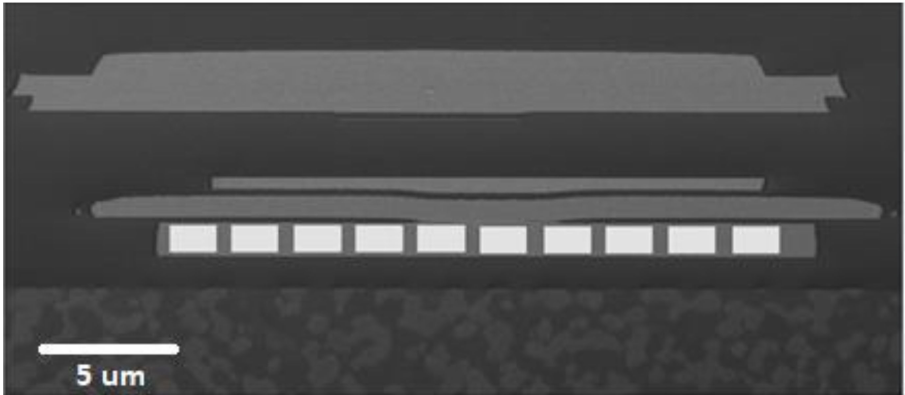
Figure 1. SEM back-scattering contrast image of reader and writer blocks, showing the NiFe substrate and, schematically, the location of the 10 (1.5 × 1.0 µ m 2 ) EDX maps. The ultra-thin DLC film growth direction upon deposition is perpendicular to the plane of the image.